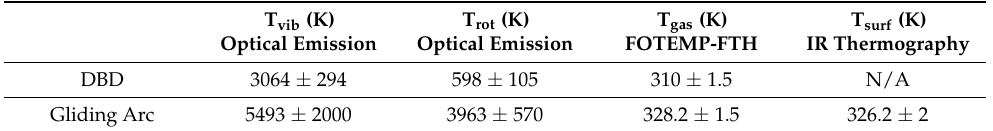
Table 1. Results for the different measured temperatures close to the epoxy samples. IR thermography was not possible in the case of